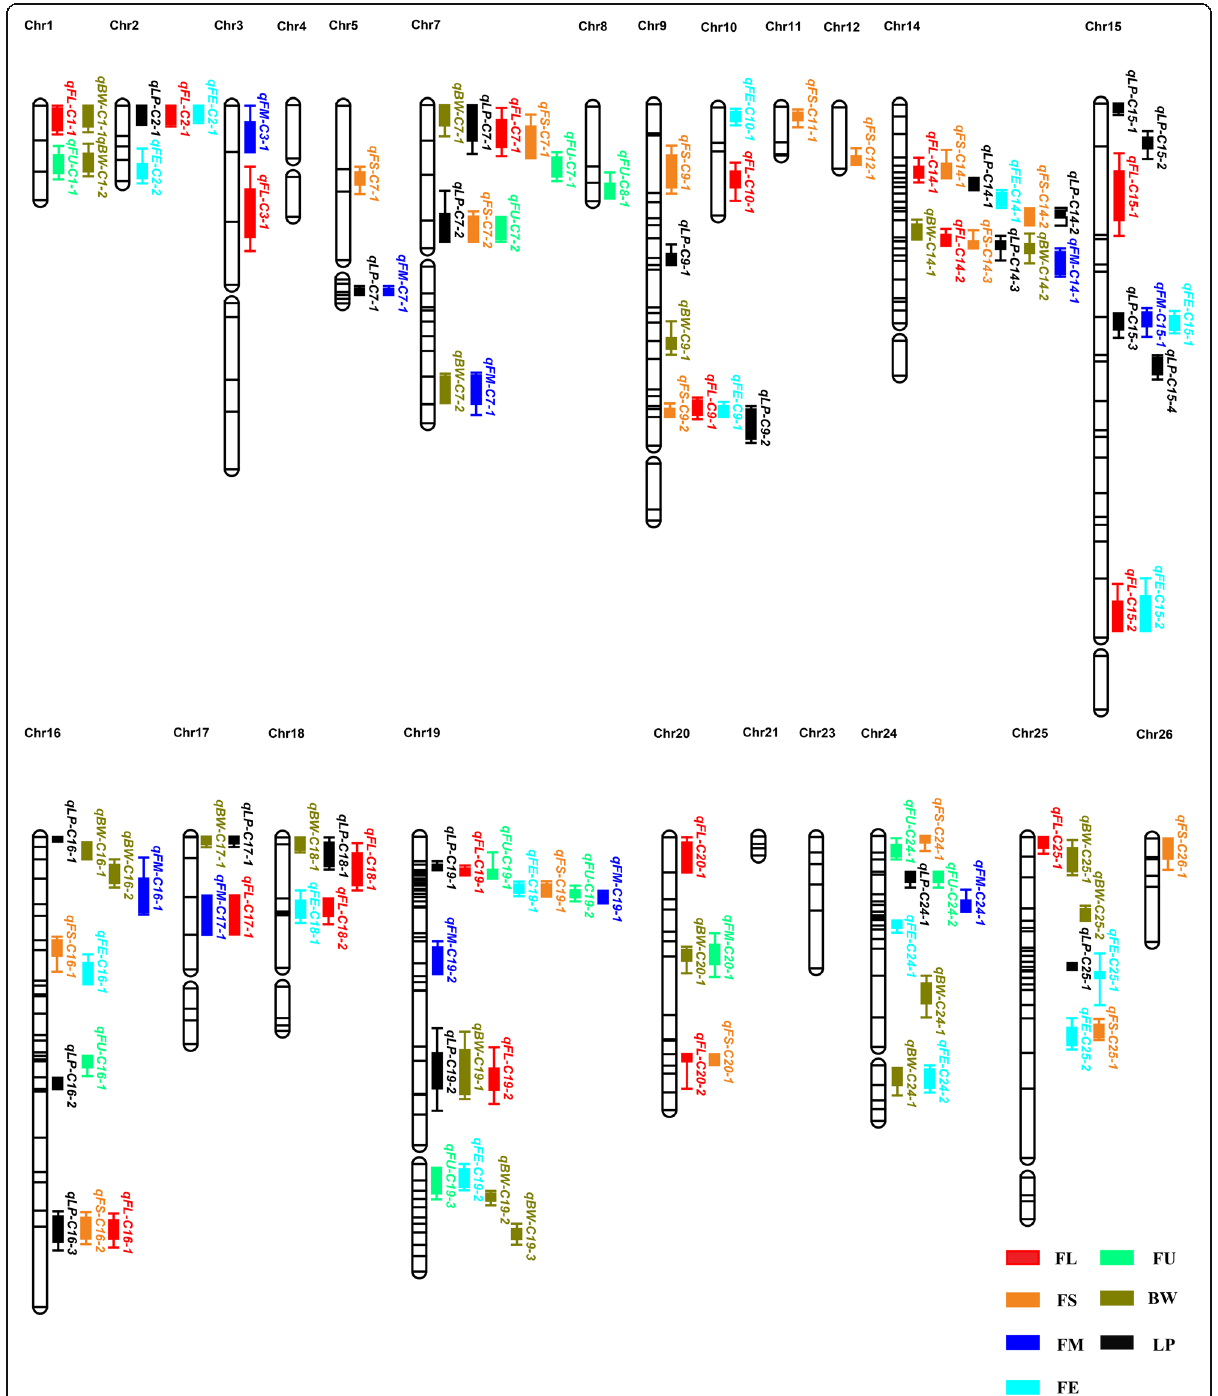
Fig. 1 Locations of QTLs for fiber quality and yield traits in four